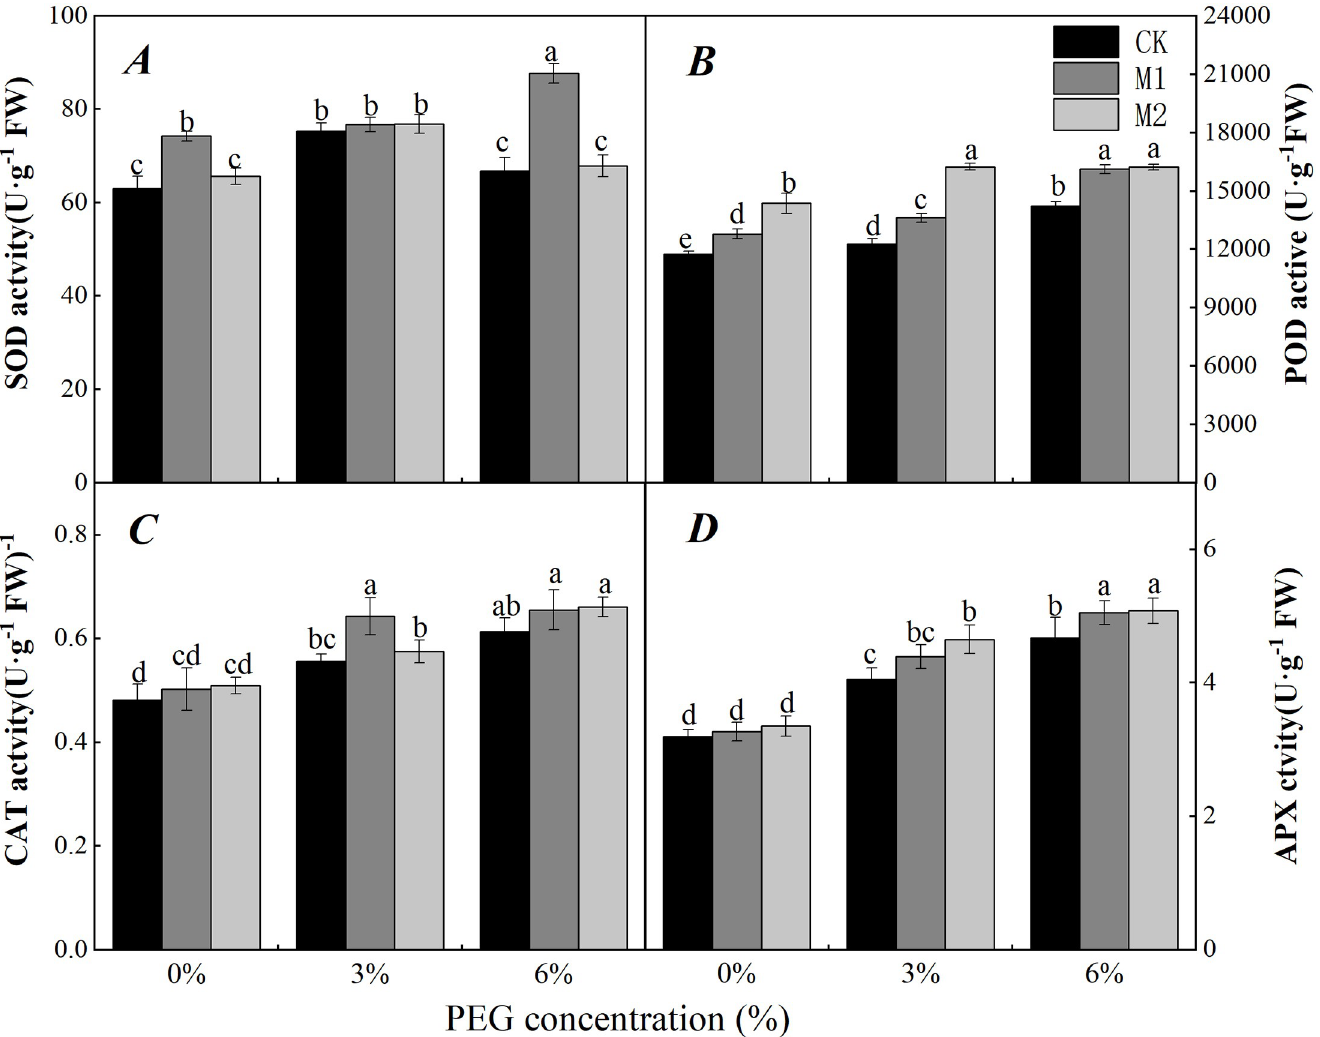
Fig 7. Effect of soaking with melatonin on antioxidant enzyme activity of soybean radicle under water stress caused by PEG. 0%, 3% and 6% were indicated 0%, 3% and 6% PEG6000 ( w/v ). Values are the means of three replicates ± S.E. Bars with different letters are significantly different at P � 0.05.